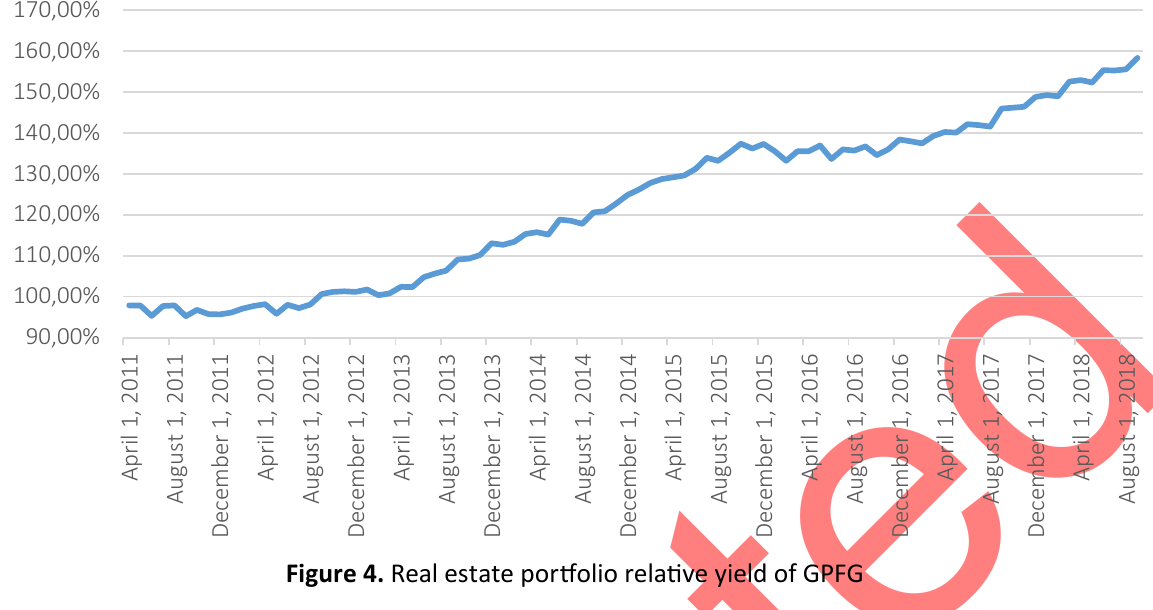
Figure 4. Real estate portfolio relative yield of